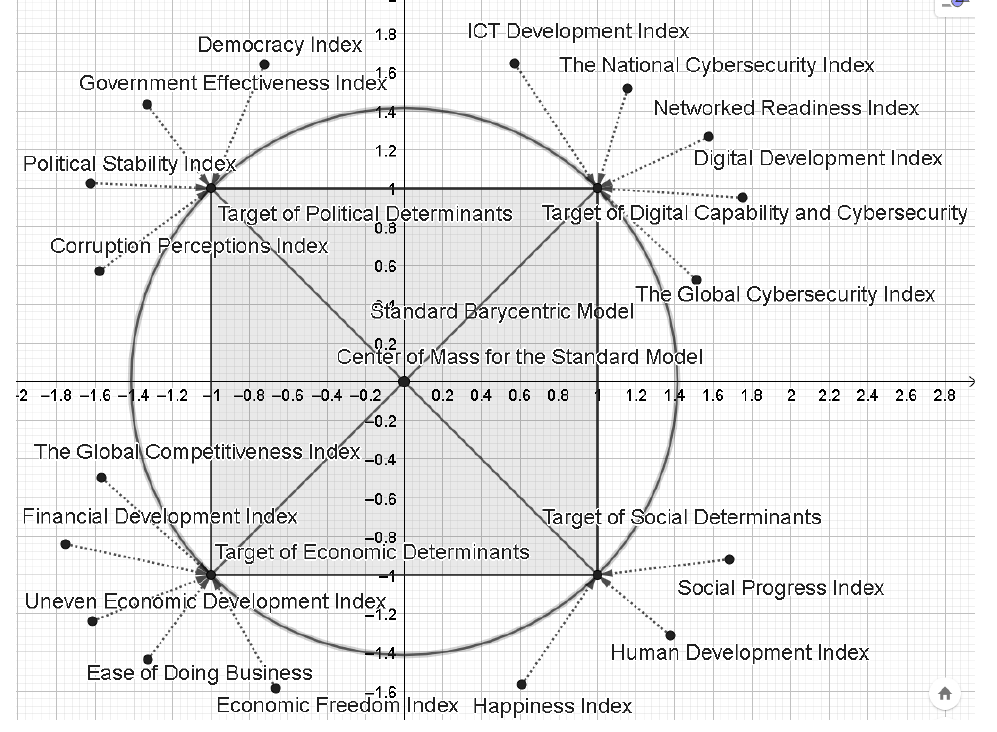
Figure 1. Standard four–pole barycentric model of country’s balanced development. Source :